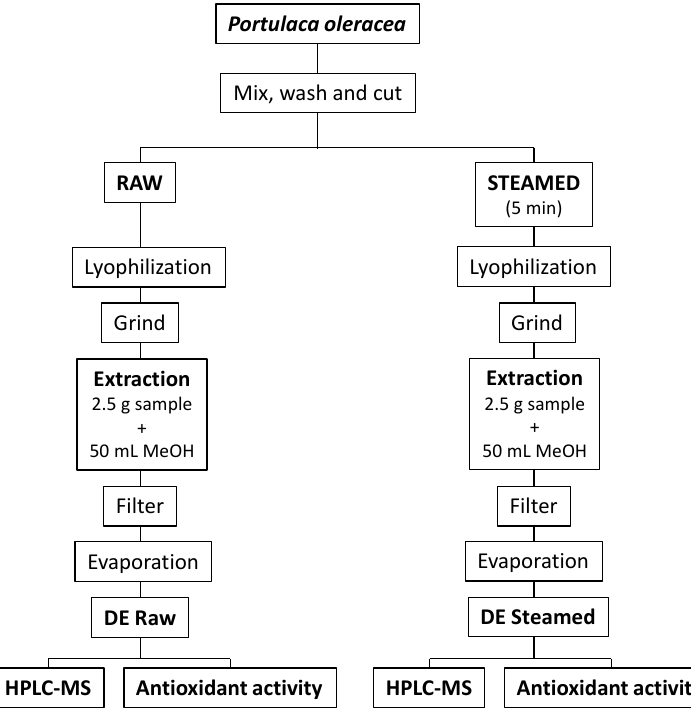
Figure 2. Scheme of the experiments. DE: Dried extract.